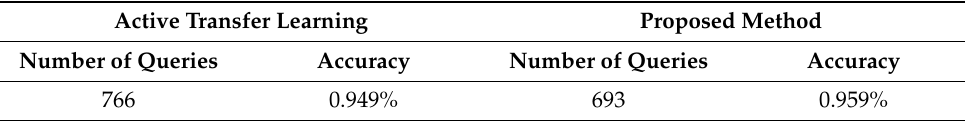
Table 9. Comparison of the number of queries and maximum accuracy (DNN,